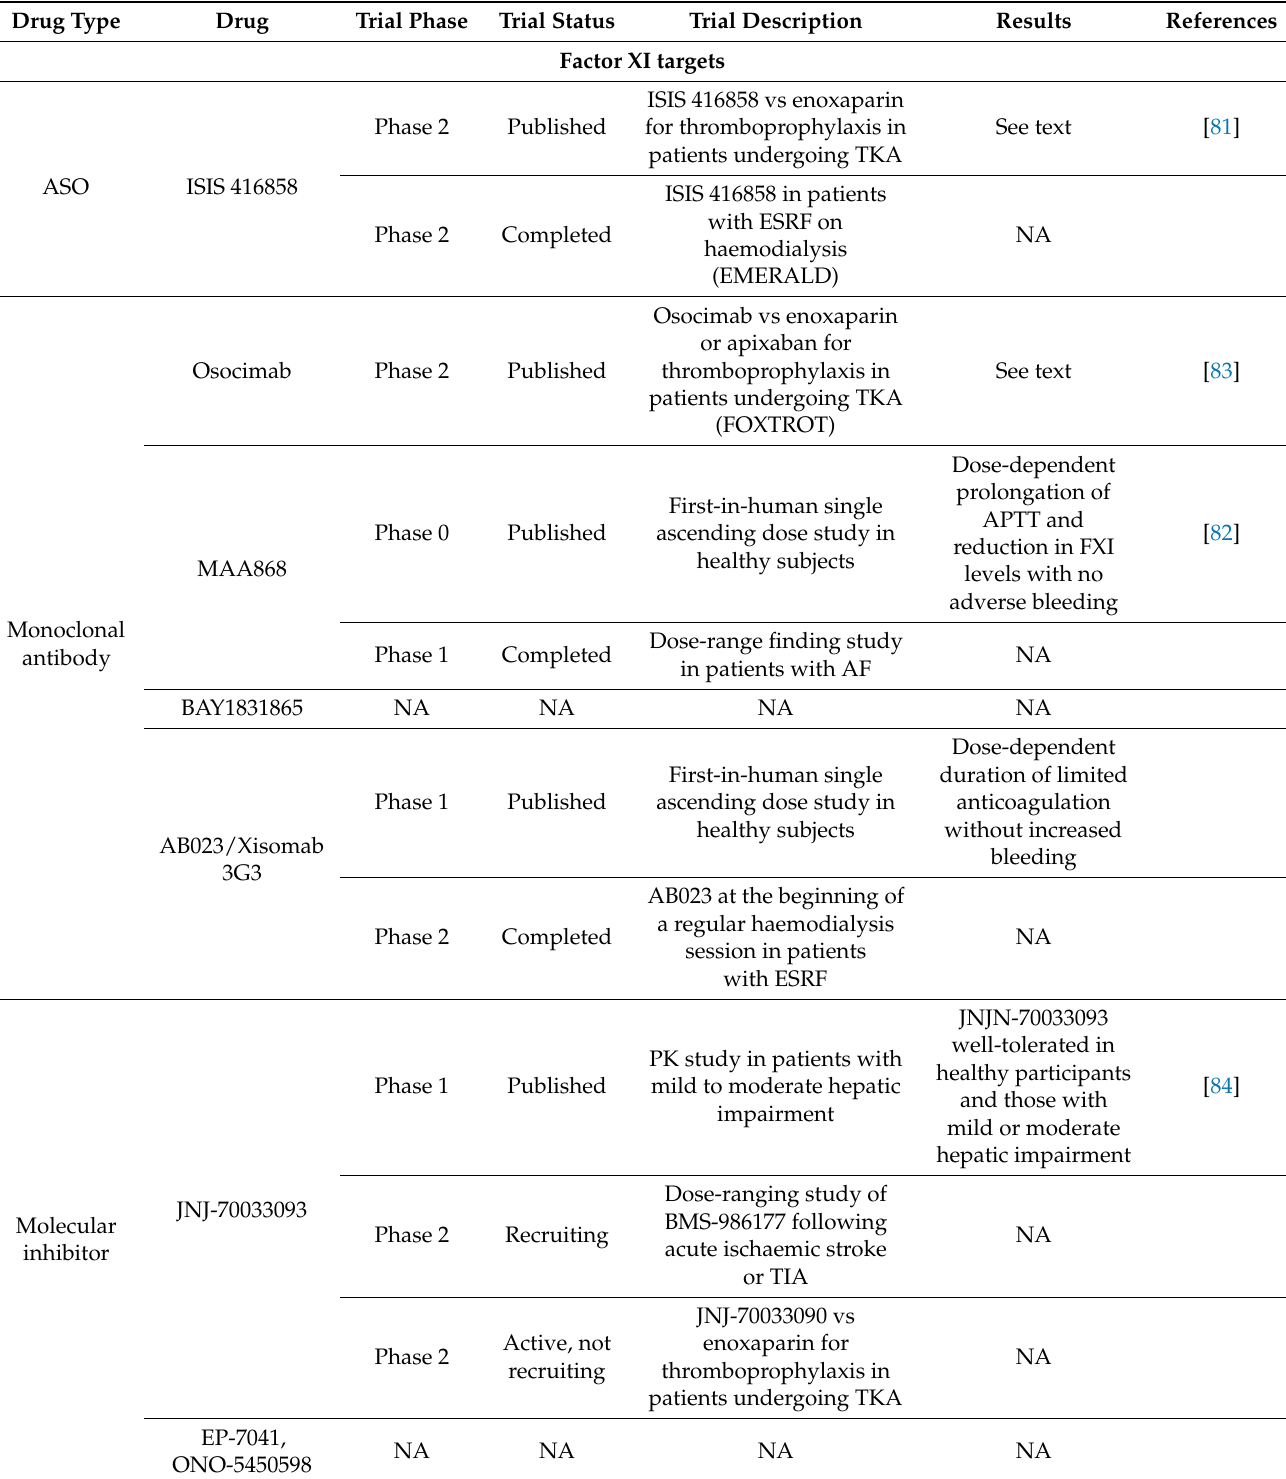
Table 2. Novel anticoagulant therapies and clinical